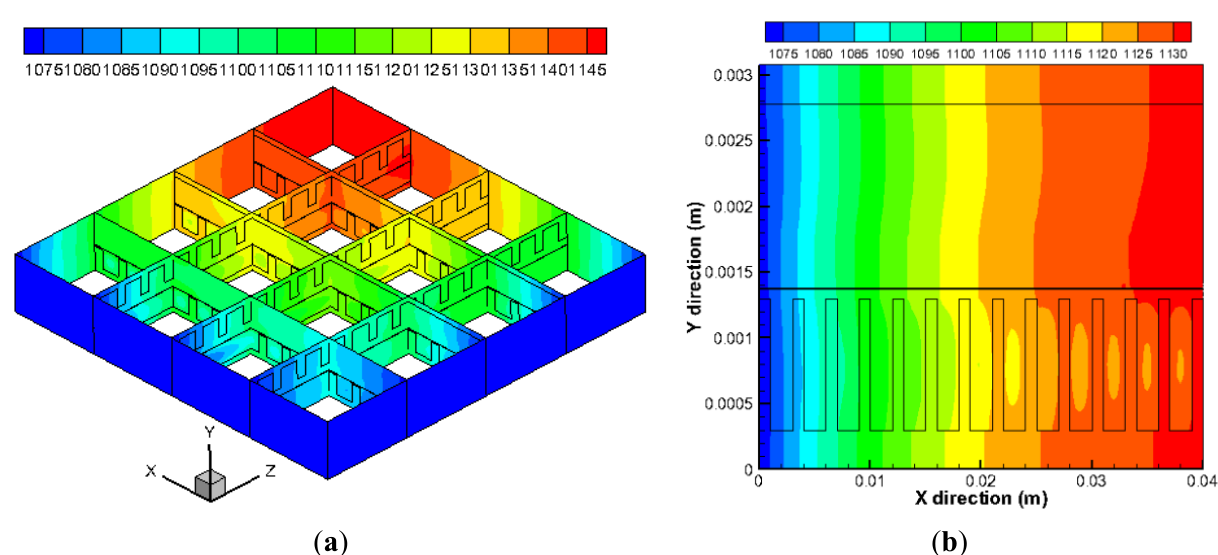
Figure 4. Temperature (K) distribution (not in scale): ( a ) inside the cell; ( b ) in the plane ( z = 0.02 m).